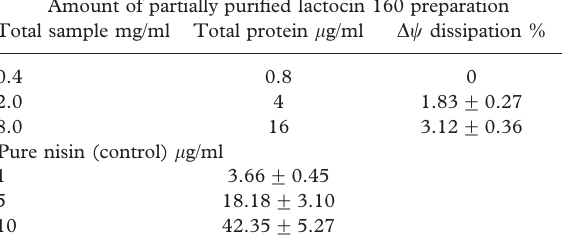
Table I. Dissipation of D c in M. luteus ATCC 10420 by lactocin 160.